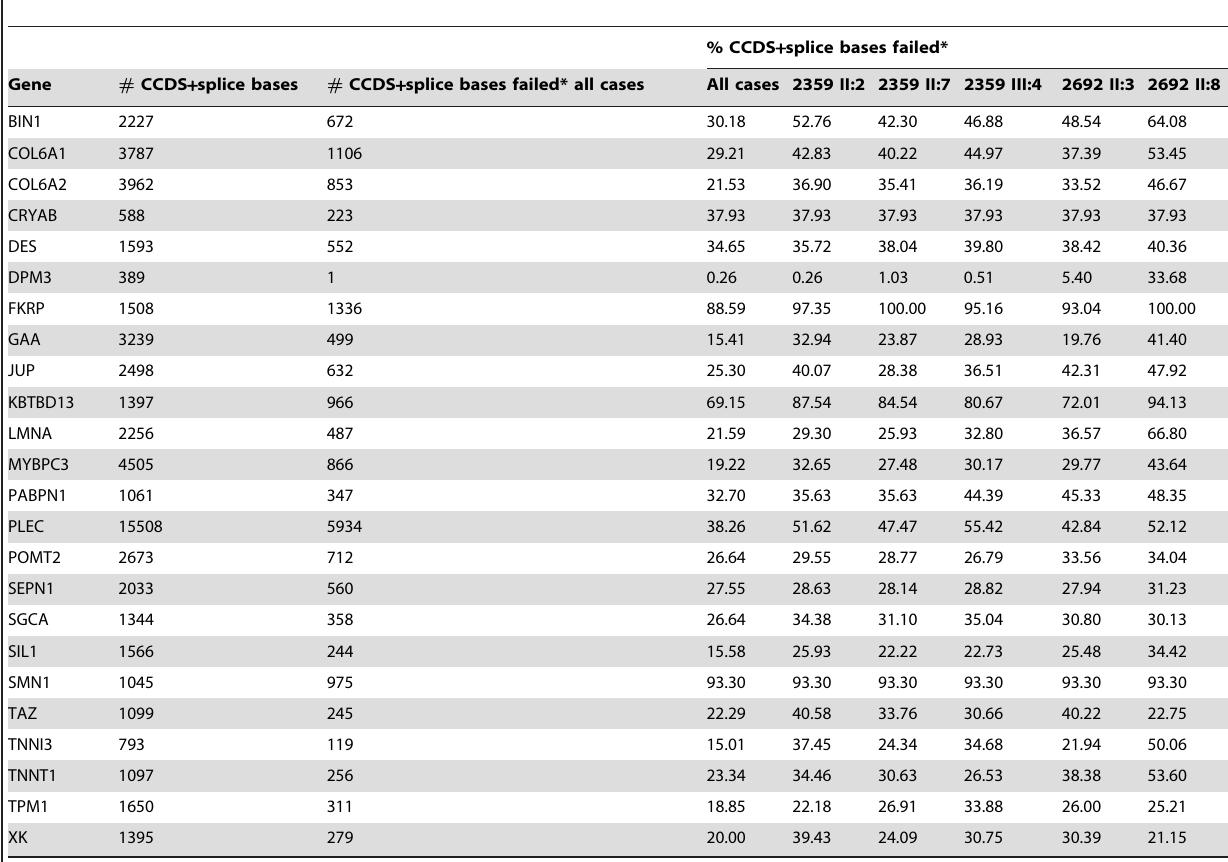
Table 2. Known muscle disease genes in which $ 30% of CCDS + splice bases have , 10X coverage and/or QUAL scores of , 50 in at least one